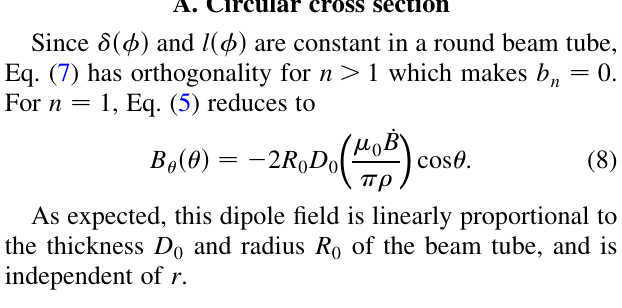
This sextupole component represents the major order of multipole field response from an elliptical beam tube.